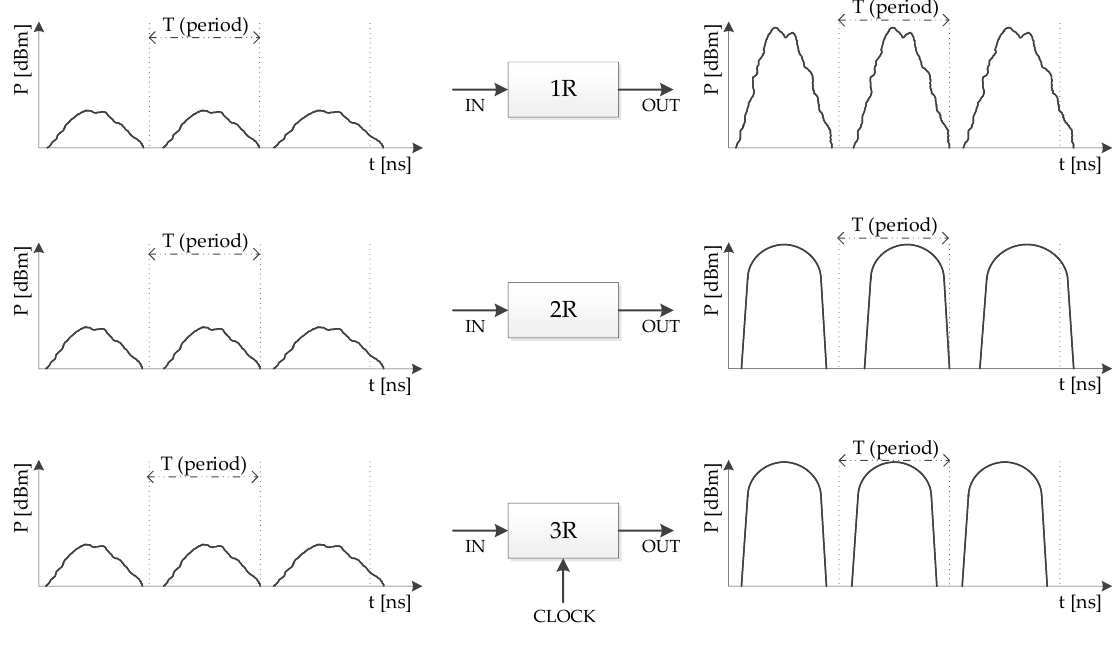
Figure 1. Principle of 1R, 2R and